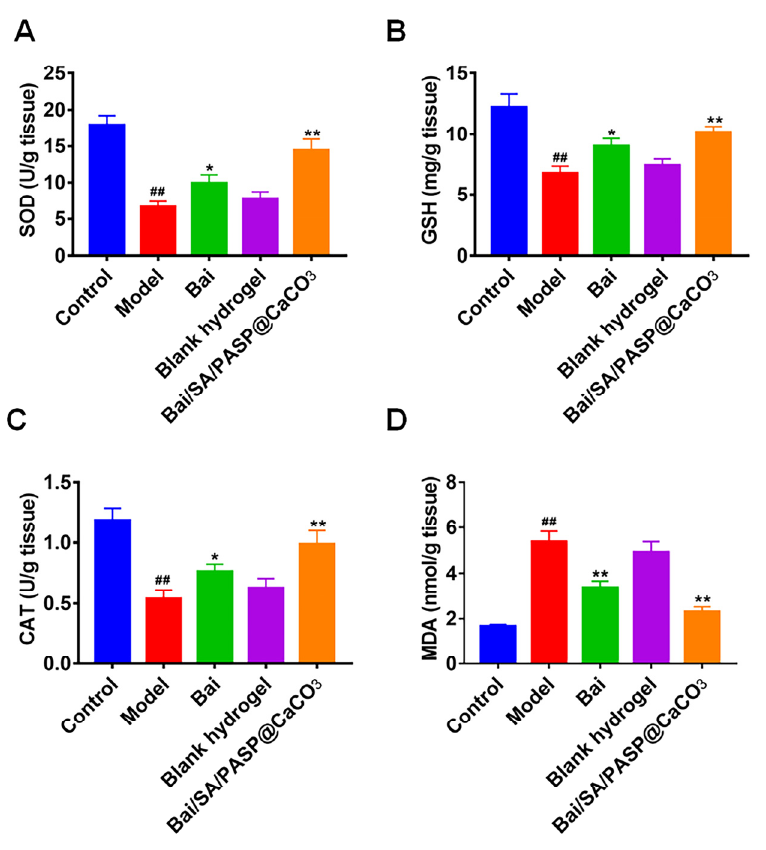
Figure 8. Effect of hydrogel on SOD ( A ), GSH ( B ), CAT ( C ), and MDA ( D ) activities in acetic acid- induced chronic gastric injury in vivo. Data are presented as mean ± SD ( n = 3). ## p < 0.01 vs. the control group, and * p < 0.05 and ** p < 0.01 vs. the model group.